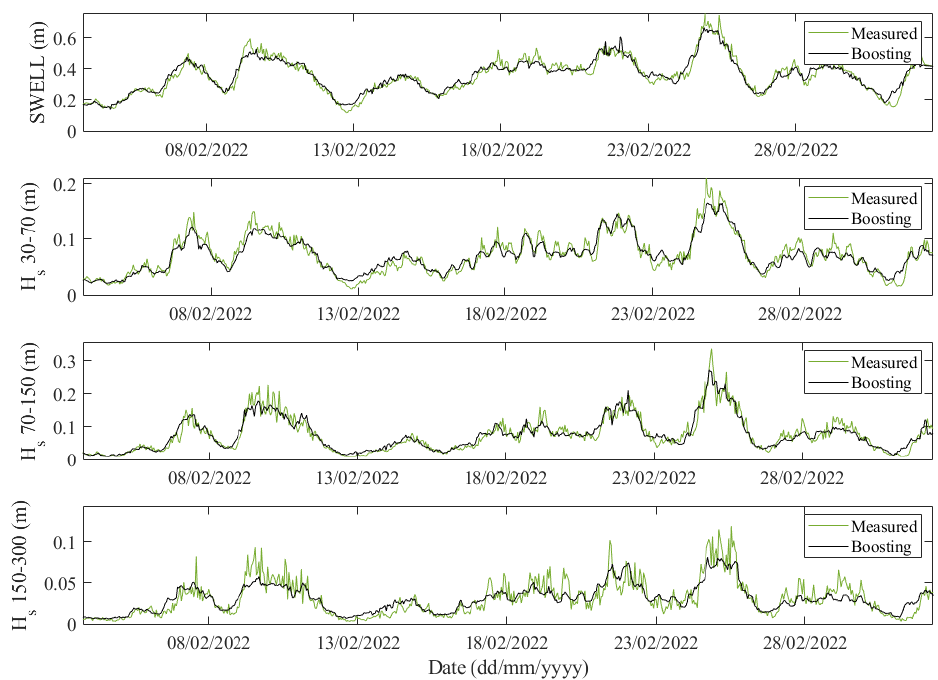
Figure 7. Measured and predicted data with the formula and with GBM of the H s in sensor S3 for the different frequency ranges.